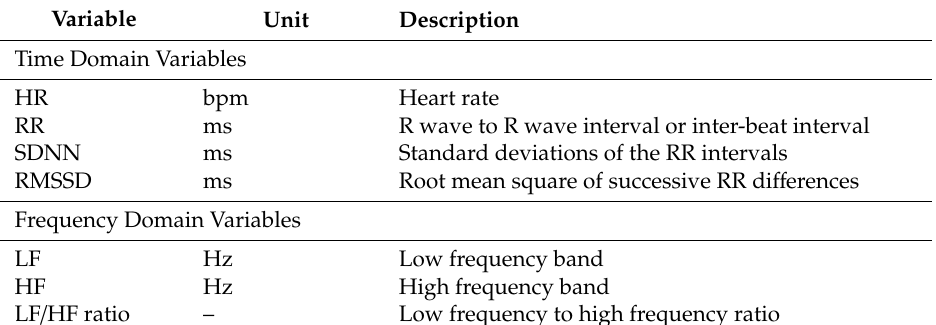
Table 1. Description of the time domain and frequency domain measures used in the present